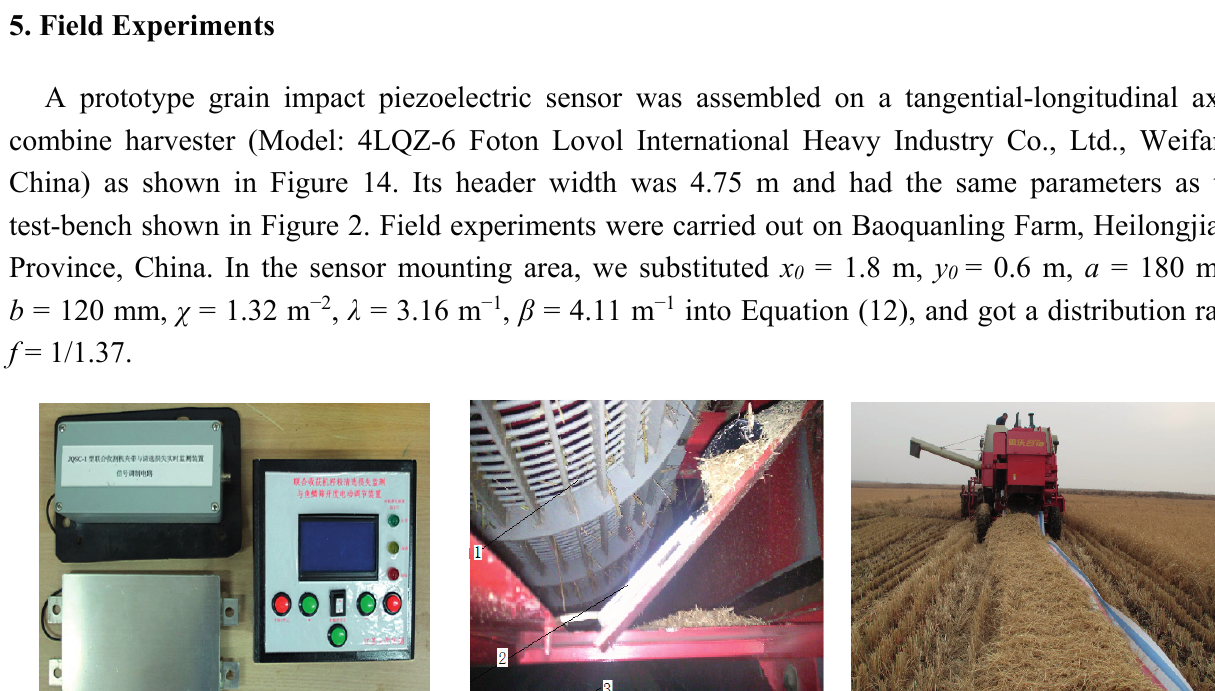
Figure 13. Output signal’s waveform of grain collision under vibration interference.